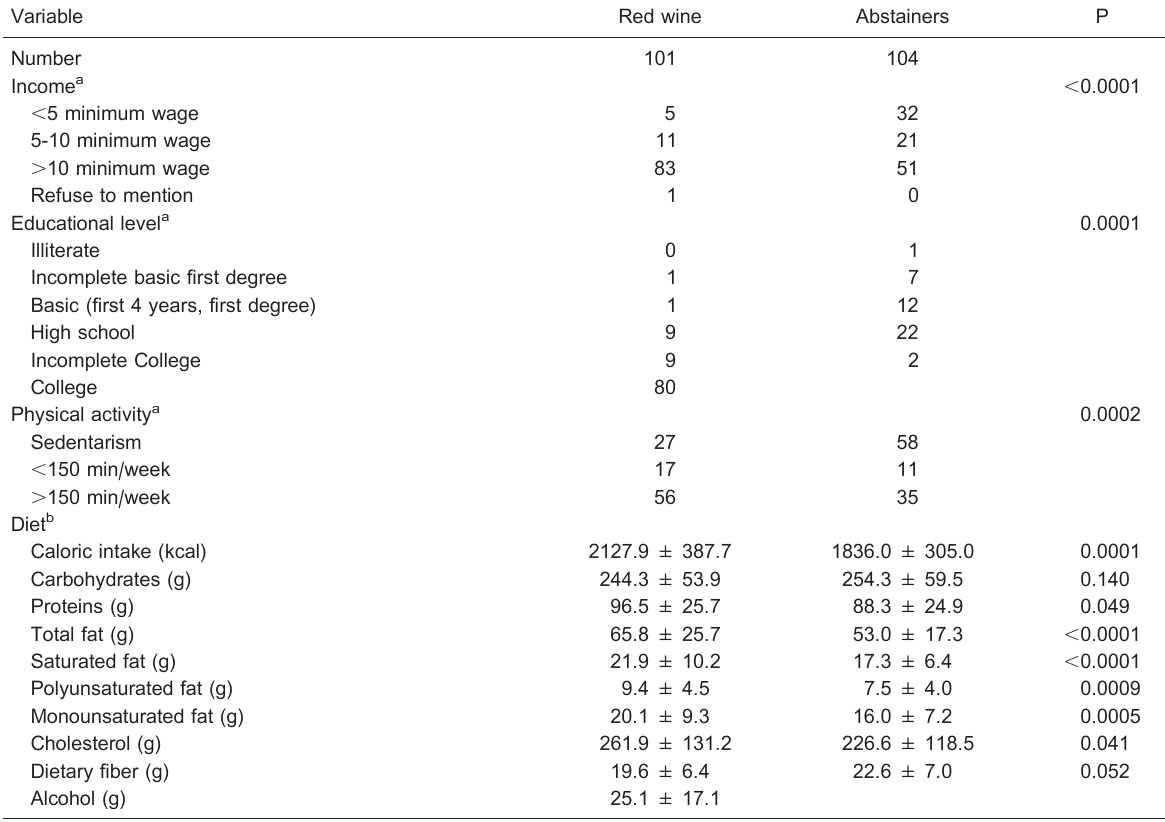
Table 4. Social and educational characteristics and daily food